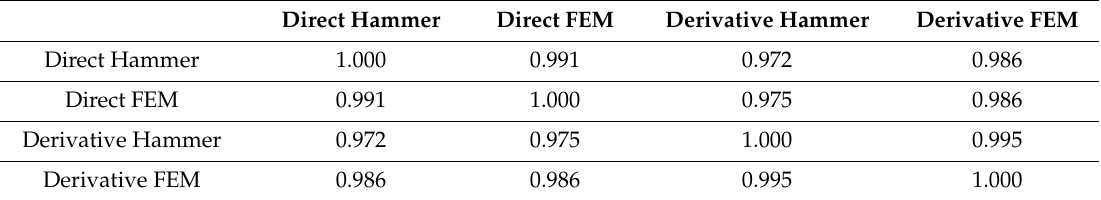
Table 7. MAC values for the second rotational mode for the UHPC1_L beam. Intact state.